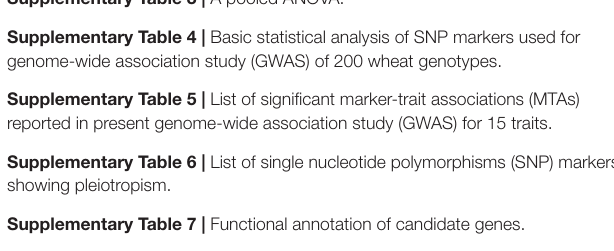
Supplementary Table 1 | Details of 200 genotypes used in the present study. Supplementary Table 2 | Analysis of phenotypic data of traits studied in a diverse panel. Supplementary Table 3 | A pooled ANOVA.